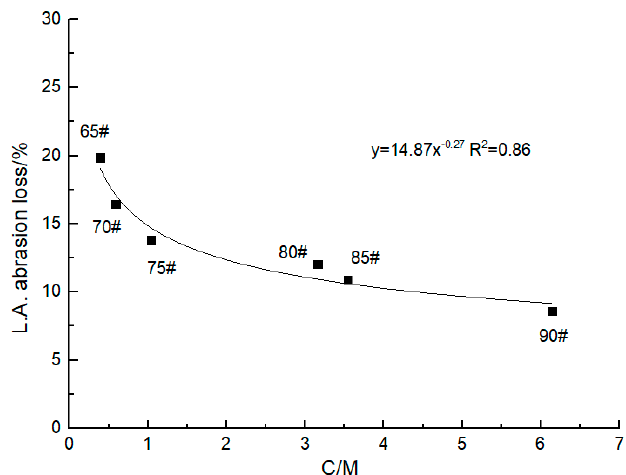
Figure 17. The relationship between C / M and L.A. abrasion loss.